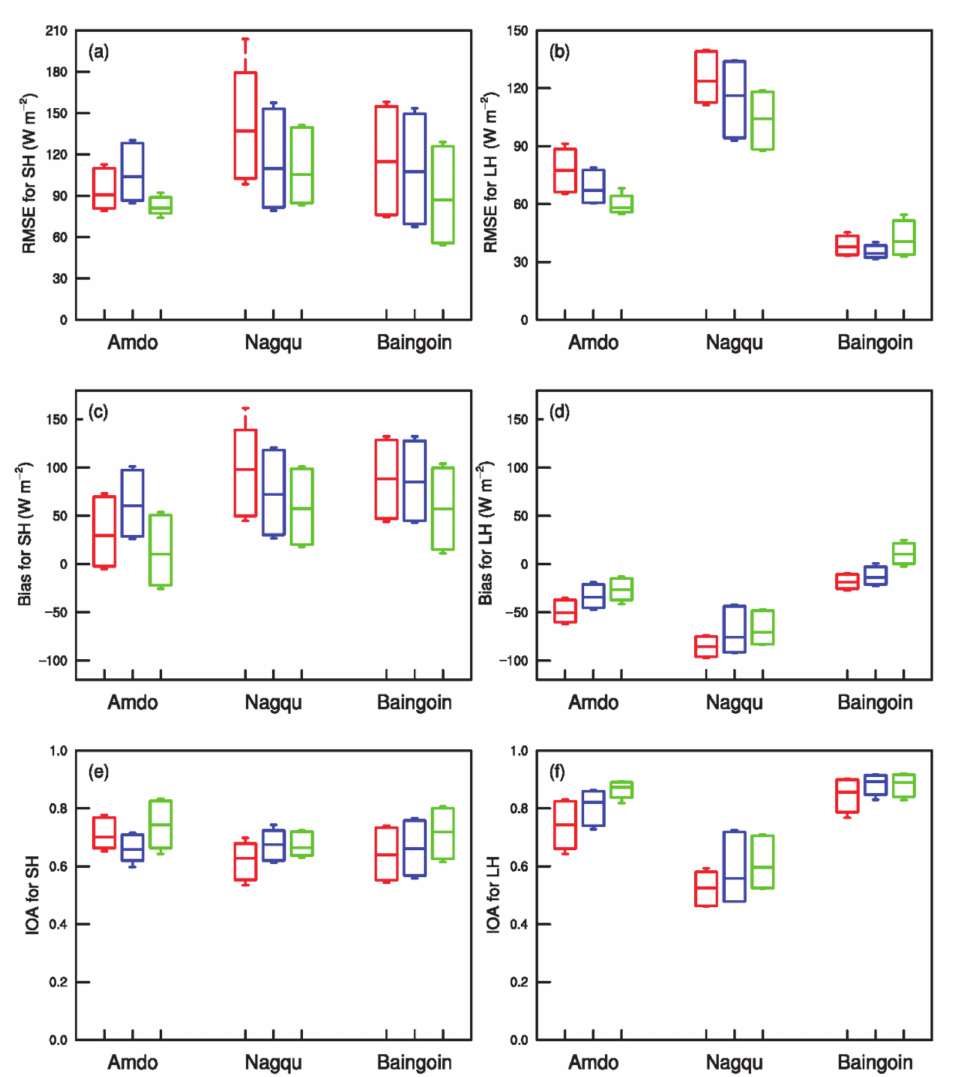
Figure 5. The minimum, median, maximum, 5%, and 95% percentile values of RMSE, bias, and IOA for SH (( a ), ( c ), and ( e )) and LH (( b ), ( d ), and ( f )) respectively in Ens1–Ens3 (red: Ens1; blue: Ens2; green: